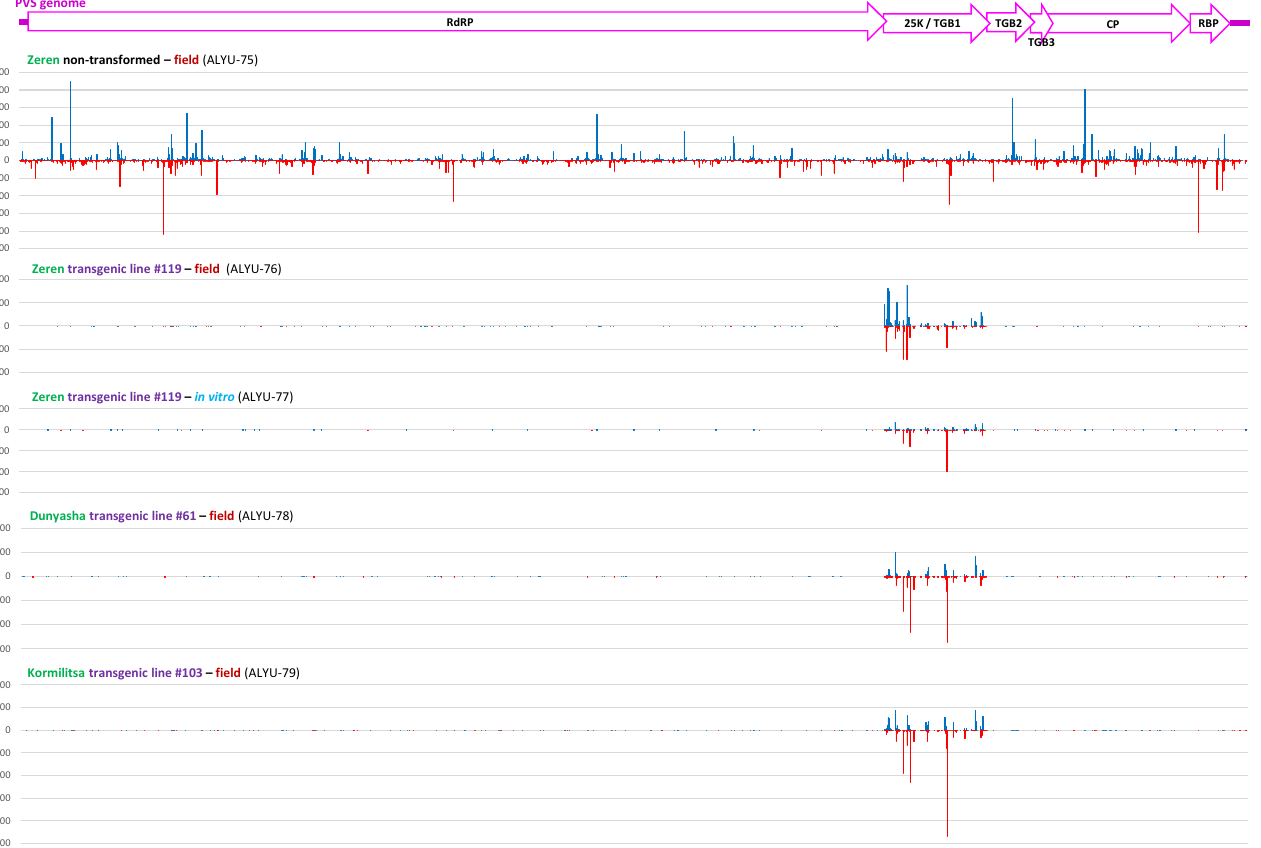
Figure 4. Single-nucleotide resolution maps of viral sRNAs from a PVS-infected non-transformed plant and transgene-derived sRNAs from PVS-free transgenic plants mapped on the PVS genome. Redundant 15–34 nt sRNA reads from the non-transformed Zeren plant (field plant ALYU-75) and the transgenic plant lines of cultivars Zeren (line #119: field plant ALYU-76 and in vitro plant ALYU-77), Dunyasha (line #61: field plant ALYU-78), and Kormilitsa (line #103: field plant ALYU-79) were mapped with zero mismatches to the PVS genome sequence (reconstructed from ALYU-75), and single-nucleotide resolution sRNA maps were created by using MISIS-2 [28] (Dataset S3). The histograms plot the number of 15–34 nt sRNA reads at each nucleotide position of the 8505 bp PVS genome. Bars above the axis represent sense (forward) reads starting at each respective position; those below represent antisense (reverse) reads ending at the respective position. The PVS genome organization is shown schematically above the histograms with conserved ORFs delineated and encoded proteins